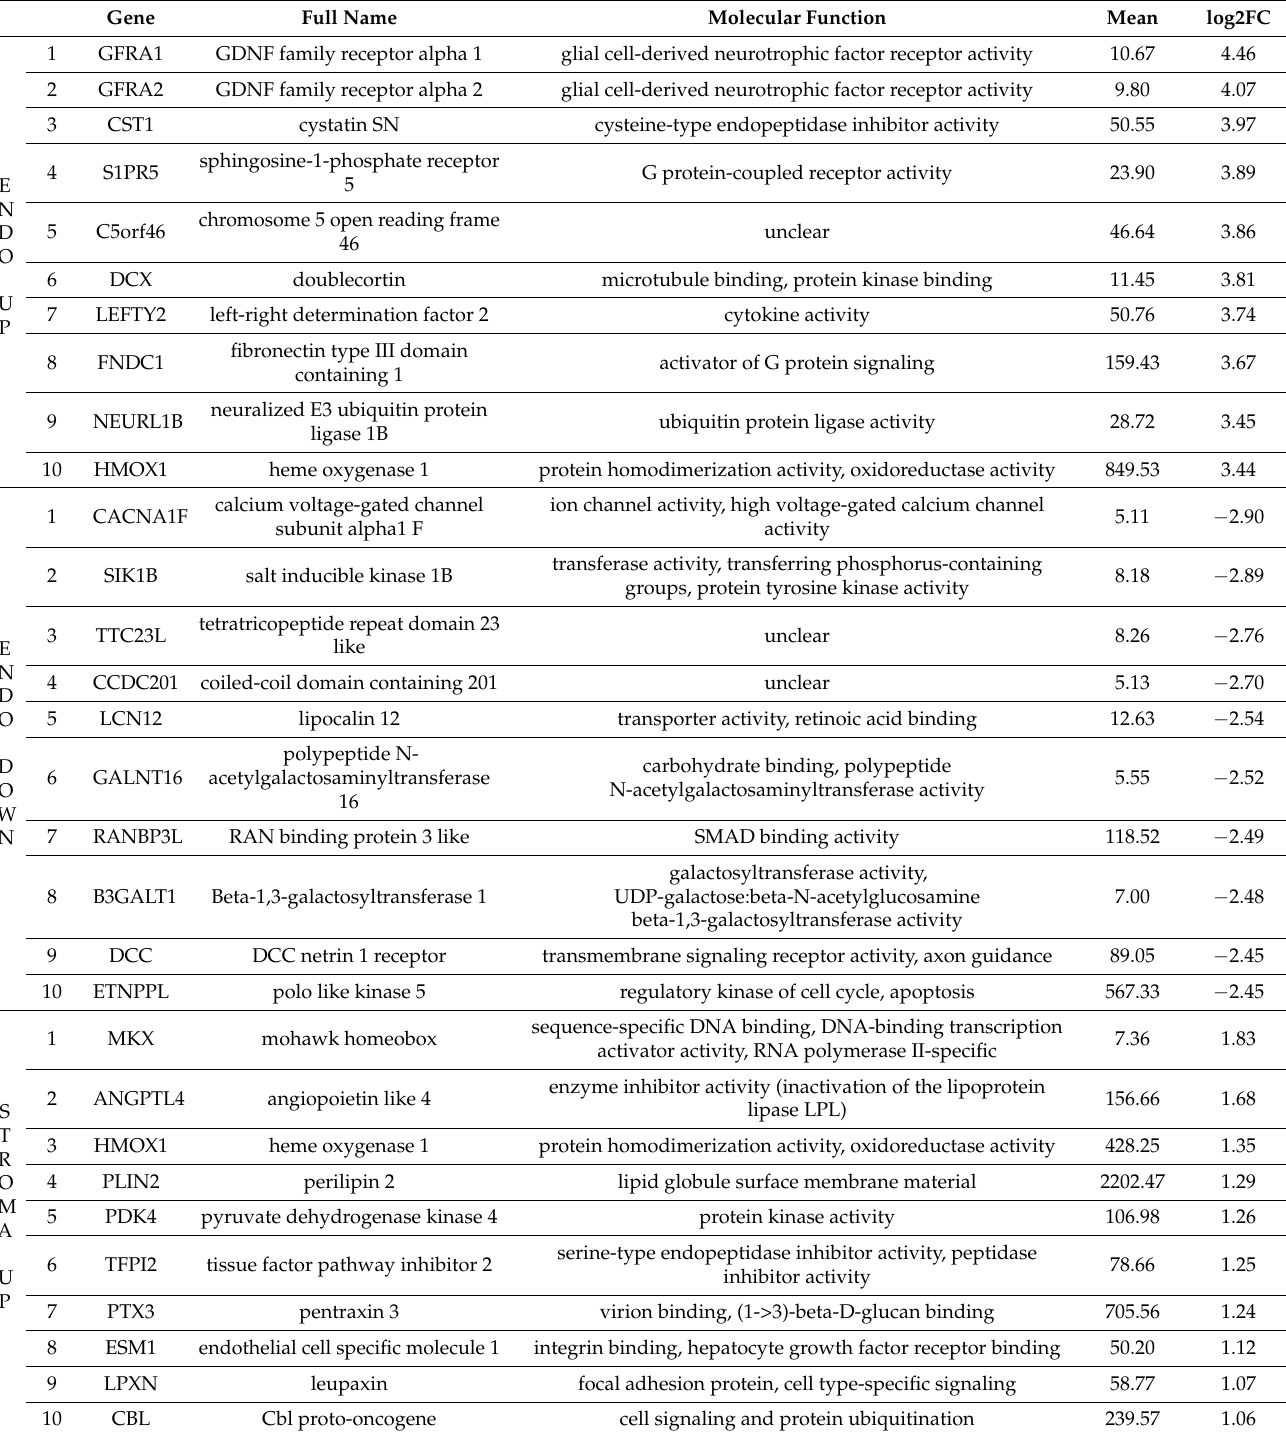
Table 4. Top 10 differentially up- and downregulated genes of the corneal endothelium and stroma following 25 days of paired culture in either 2%FBS or